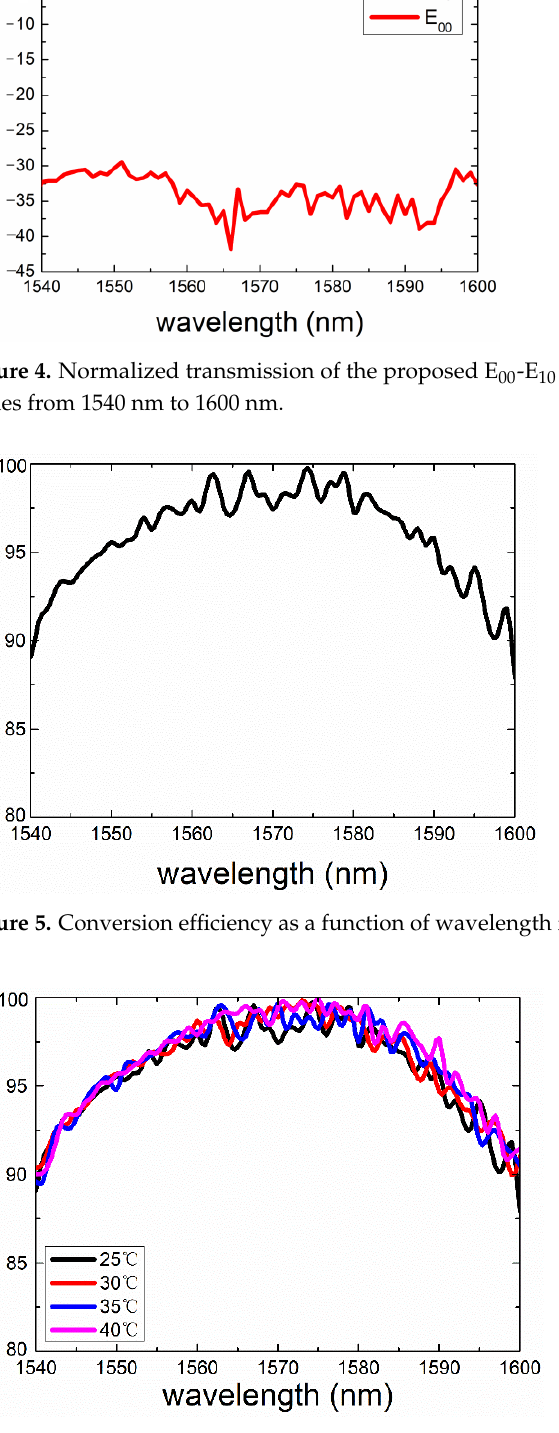
Figure 6. Simulated mode conversion as a function of wavelength at different temperatures.